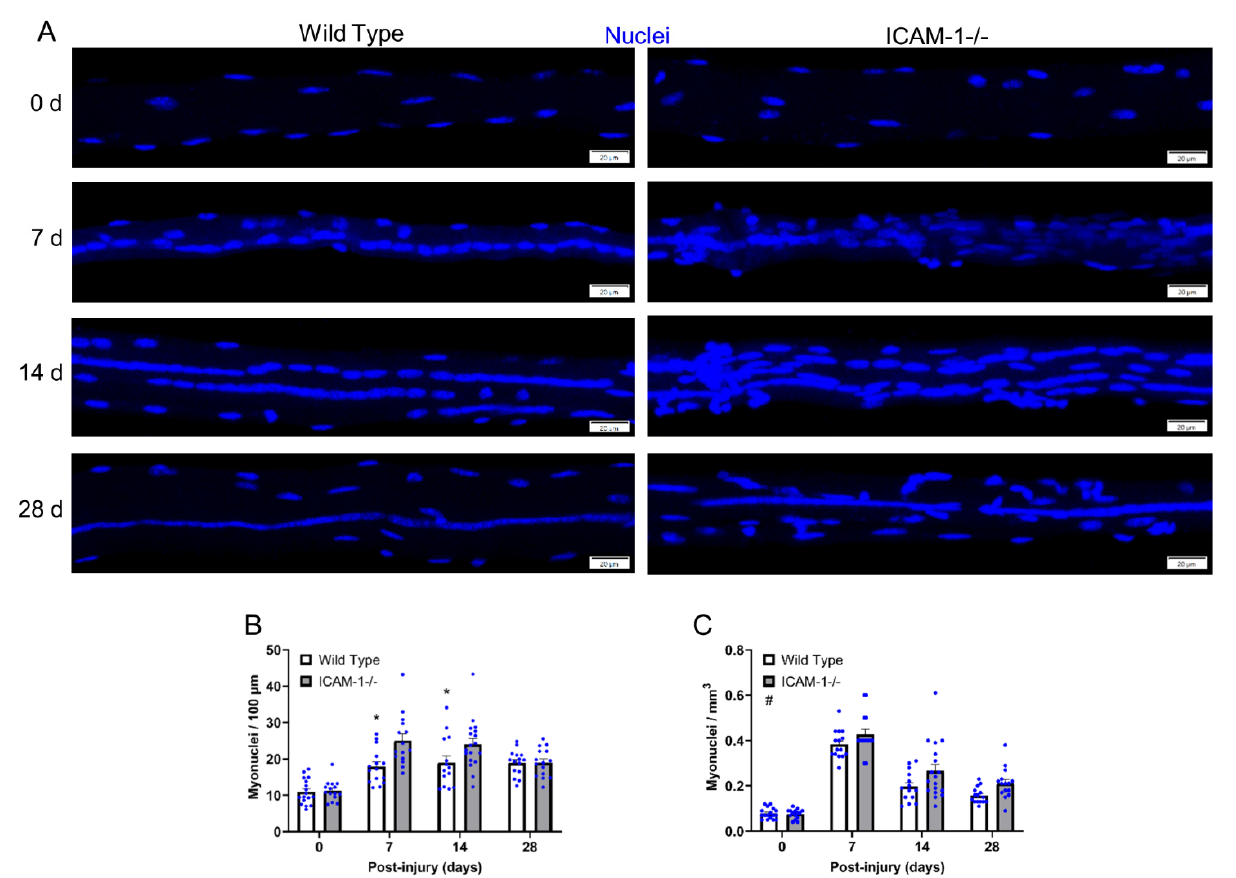
Figure 1. Myonuclear number and density before and during injury-induced muscle regeneration. ( A ) z-projection images of myonuclei (blue) in myofibers isolated at 0, 7, 14, and 28 days post-injury. Scale bars = 20 μ m. ( B ) The number of myonuclei expressed relative to myofiber length (100 μ m). ( C ) The number of myonuclei expressed relative to myofiber volume (mm 3 ). n = 14–18 myofibers/time point for each genotype. * = lower for Wild Type compared with ICAM-1-/- mice at indicated time point (interaction effect; p = 0.018). # = lower for Wild Type compared with ICAM-1-/- mice (main effect for genotype; p = 0.002).